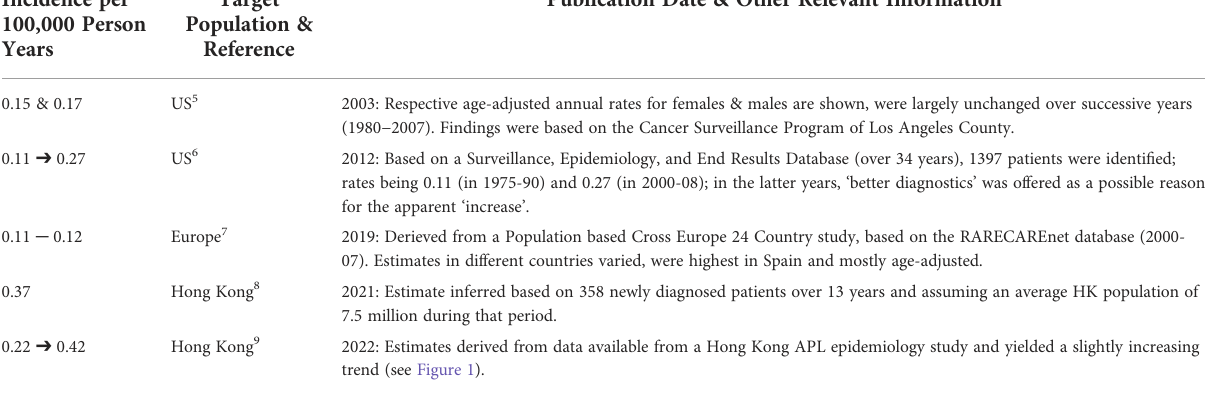
TABLE 1 Incidence estimates (number of new patients with APL encountered annually, - expressed as a proportion of a given region ’ s inferred population as cited in relevant publications). Incidence per 100,000